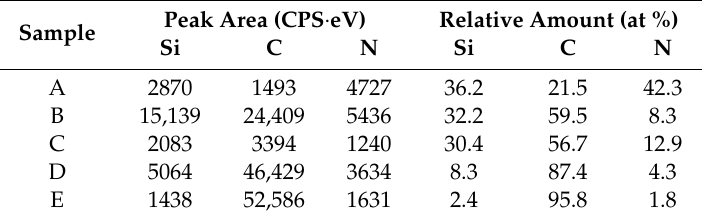
Figure 5. XPS wide scan spectra of samples with different Si/C ratios synthesized at 1550 °C. Table 2. The element contents in samples calculated from XPS spectra.